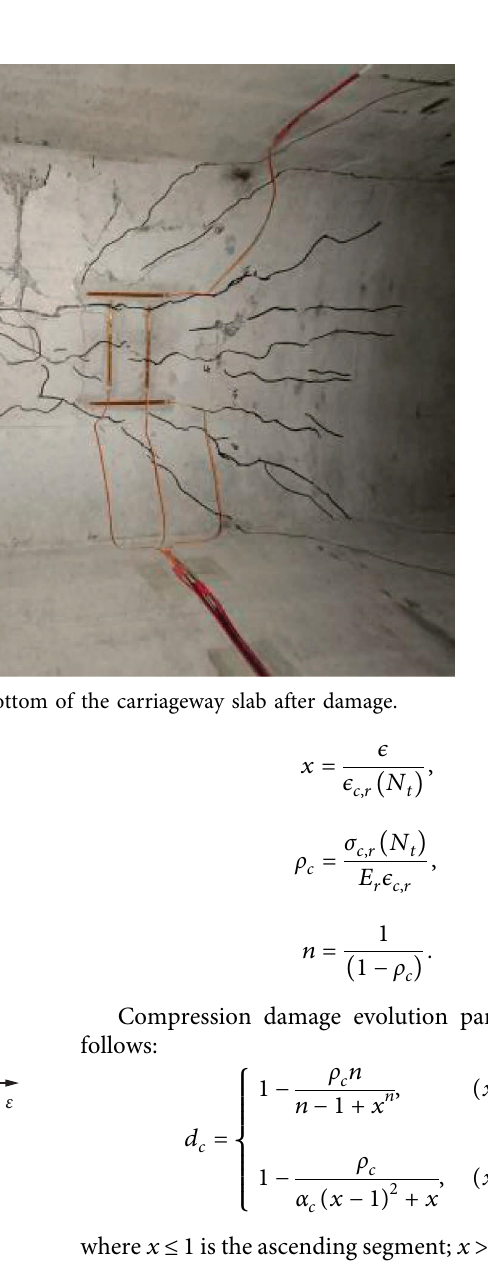
Figure 8: Uniaxial stress-strain curve of concrete.